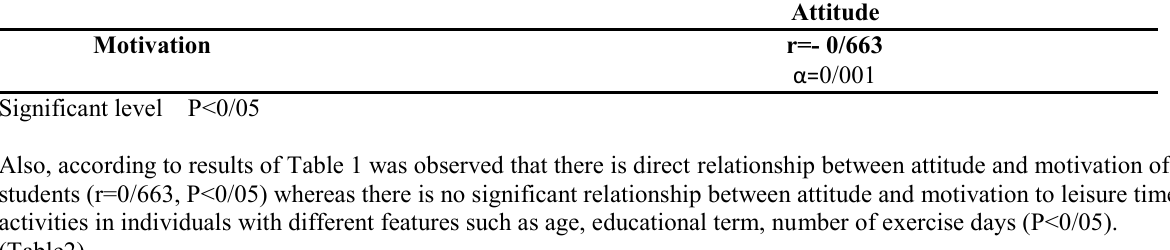
Table1: relationship between attitude and motivation with using Pearson Correlation Coefficient